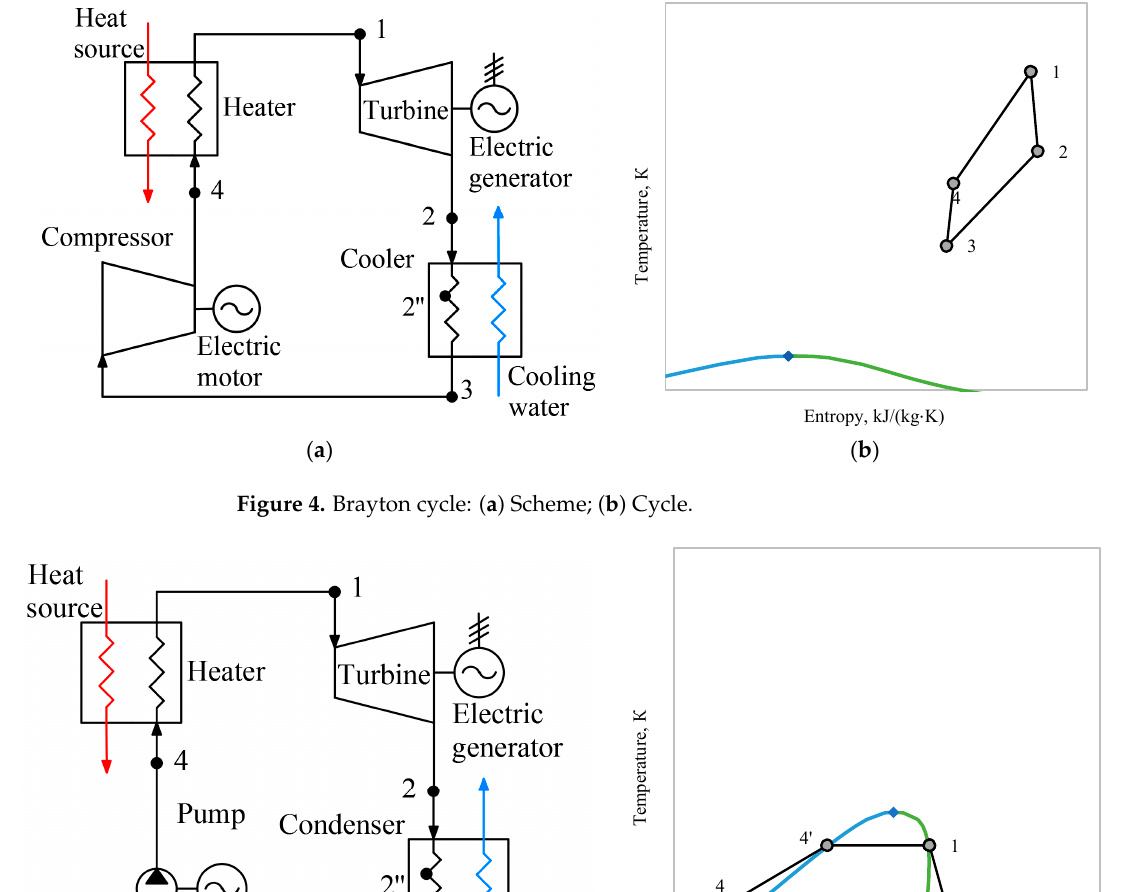
Figure 3. TS diagram of different working fluids.